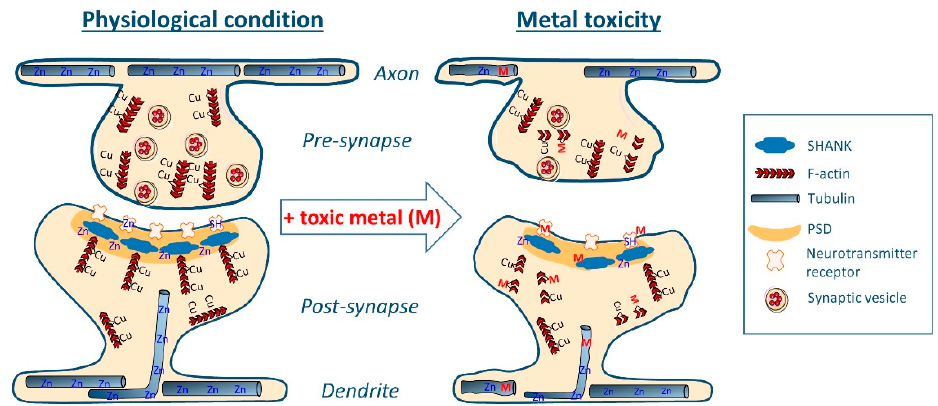
Figure 2. Schematic representation of synaptic toxicity mechanisms by direct competition of toxic metals (M) with physiological metal binding sites (Cu, Zn) within cytoskeletal proteins (e.g., tubulin, F-actin and/or F-actin binding proteins), PSD scaffold proteins (e.g., SHANK), and neurotransmitter receptors (e.g., NMDAR). These metal–protein interactions can damage the synaptic structure and lead to loss of connectivity between neurons.